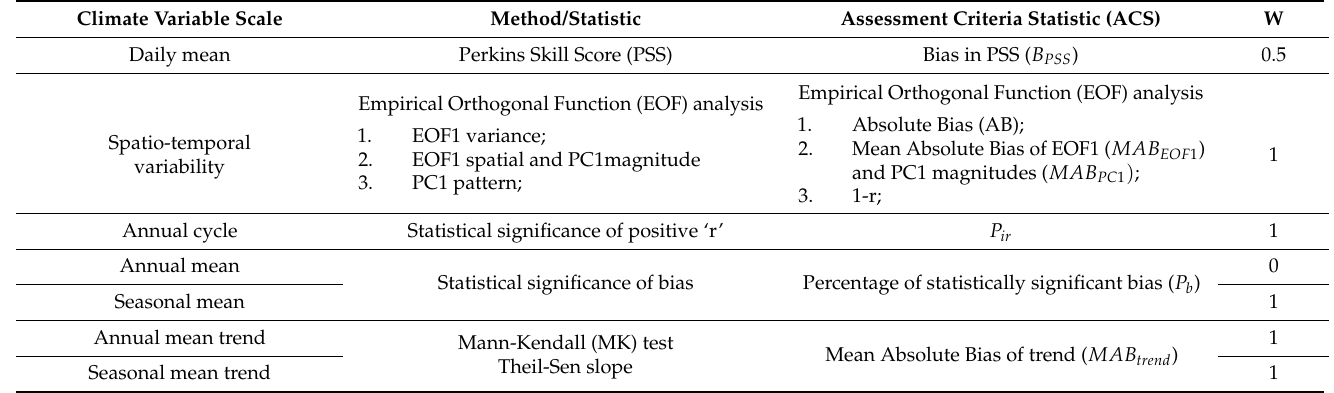
Table 2. Summary of assessment criteria statistics used for model evaluation over different climate variable